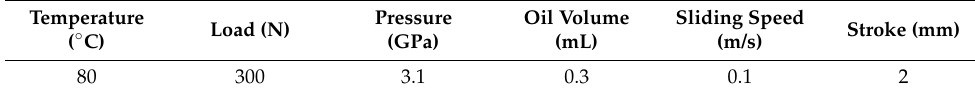
Figure 4. The curve of friction coefficient with different thickness coating.